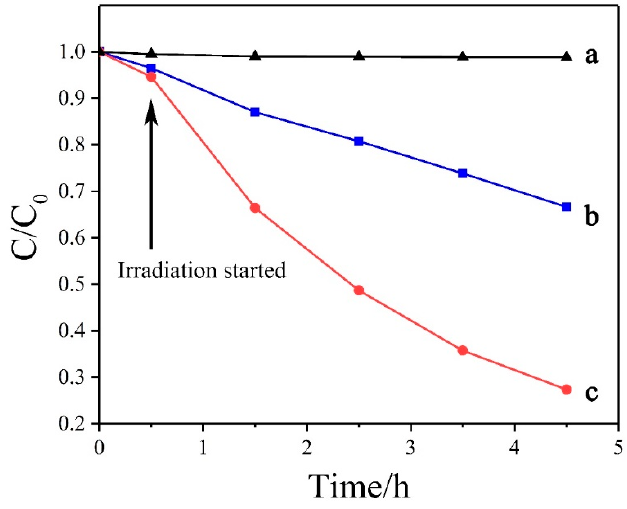
Figure 8. Schematic illustration of mechanism of citrate capping effect in: ( a ) OS route; and ( b )TS route.